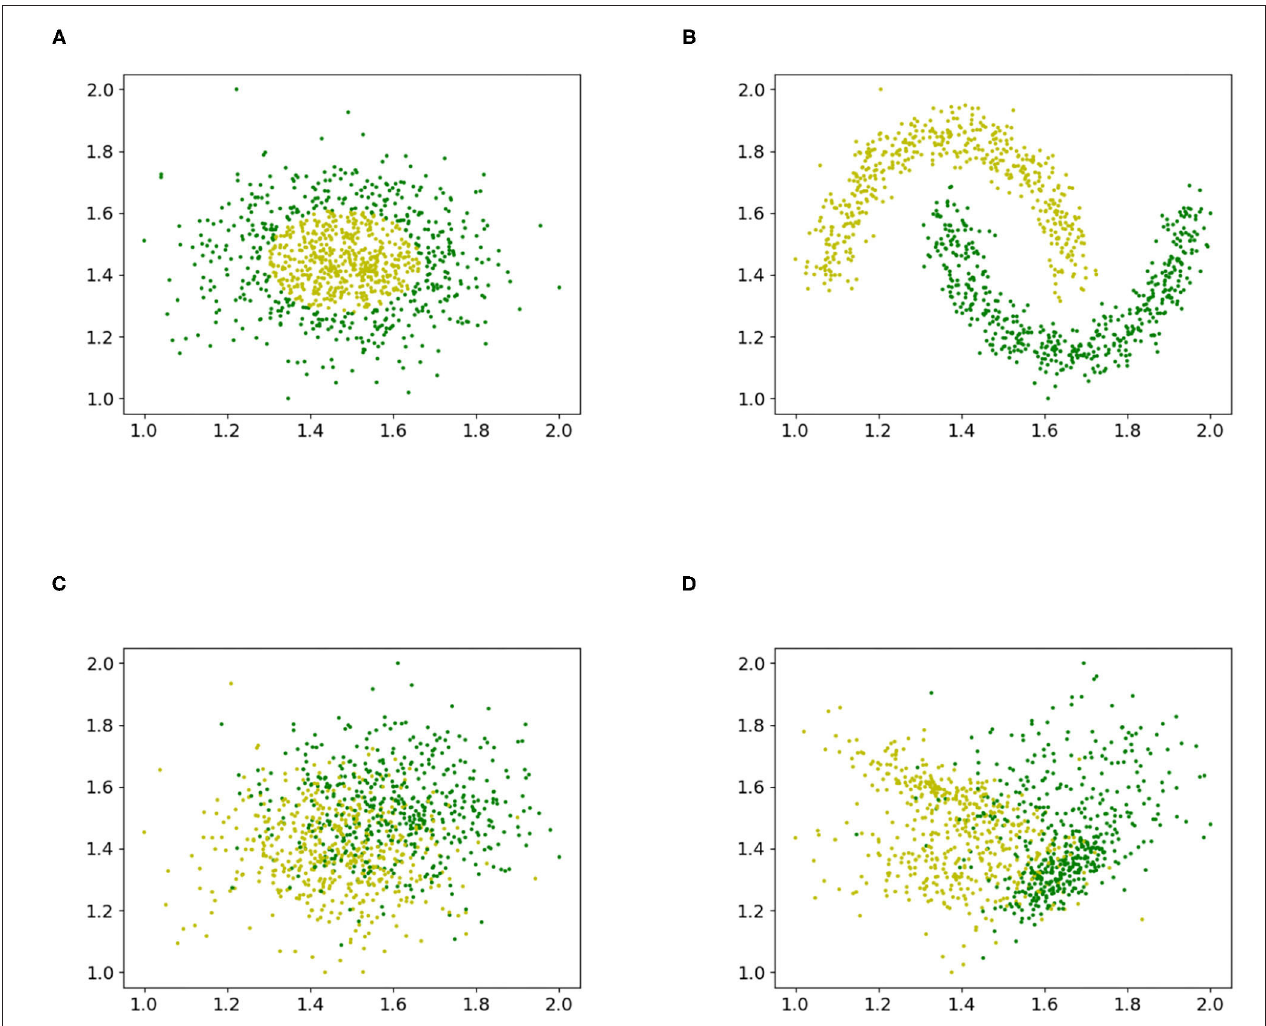
FIGURE 1 | Various artificial binary classification problems were created to study the influence of the Box-Cox transformation with a grid exploration. (A) Gaussian quantiles, (B) interleaving half circles, (C) isotropic Gaussian blobs, and (D) random